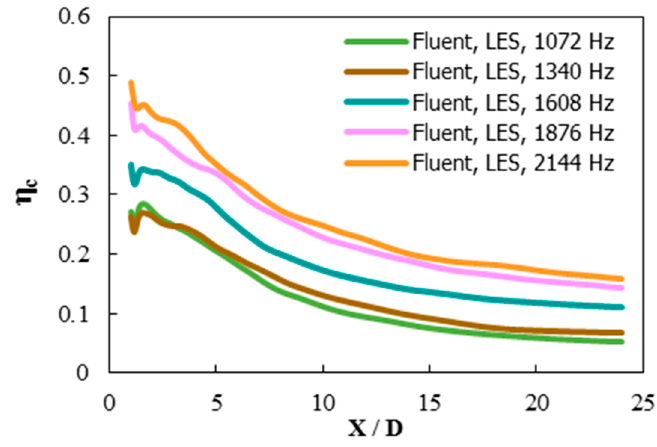
Figure 29. The centerline effectiveness obtained using the LES Smagorinsky–Lilly model for M = 0.5 for the 1072, 1340, 1608, 1876, and 2144 Hz oscillations [28].